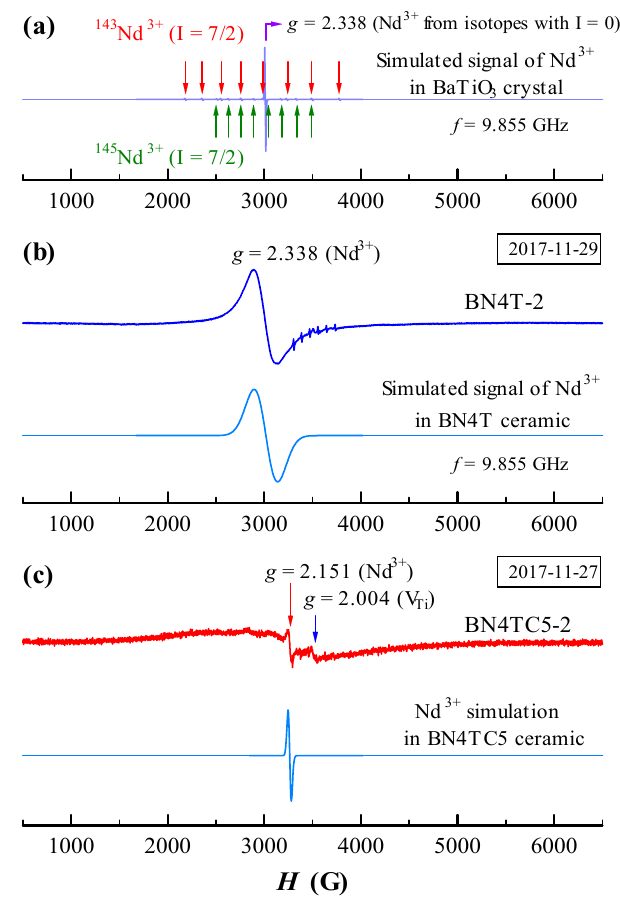
Figure 5. ( a ) Simulated ESR signal for Nd 3+ in BaTiO 3 crystal; ESR signals observed and simulated for Nd 3+ in ( b ) BN4T ‐ 2 and ( c ) BN4TC5 ‐ 2.